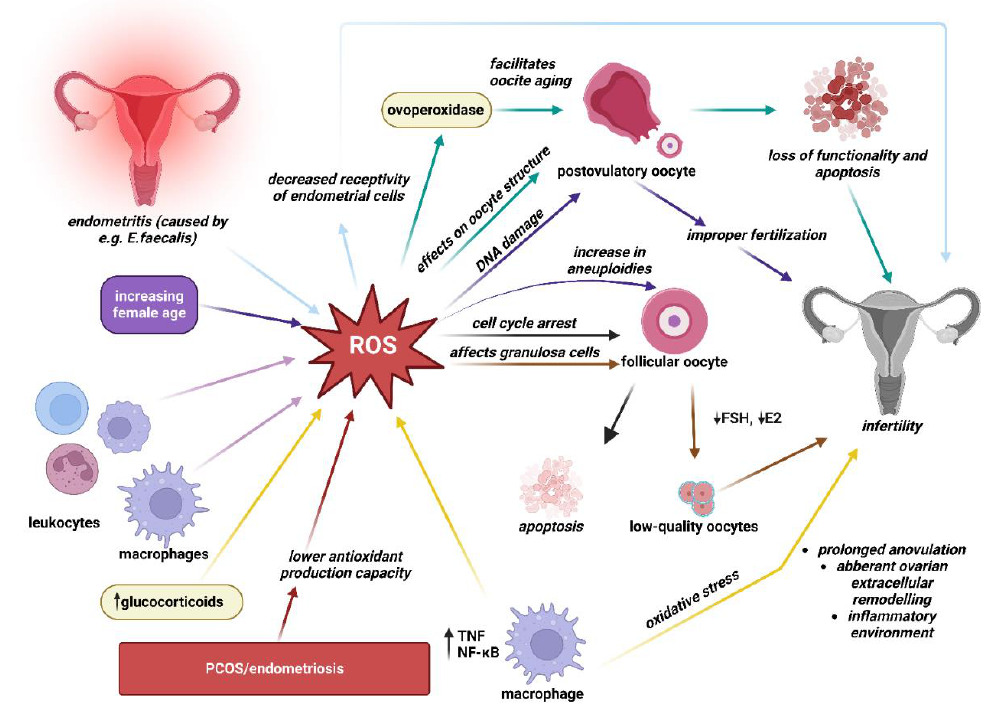
Figure 1. Identified mechanisms of oxidative stress-related infertility. The production of reactive oxygen species (ROS) during various processes (such as aging, uterine infections, etc.) and by various sources (such as leukocytes, macrophages, etc.) are illustrated via multi-colored arrows. Arrows of respective colors in turn represent the mechanisms by which ROSs may lead to infertility, e.g., E. faecalis endometritis may lead to an increase in ROS production, which in turn have an effect of decreasing receptivity of endometrial cells thus potentially leading to impaired fertility. (This figure was created with BioRender.com).